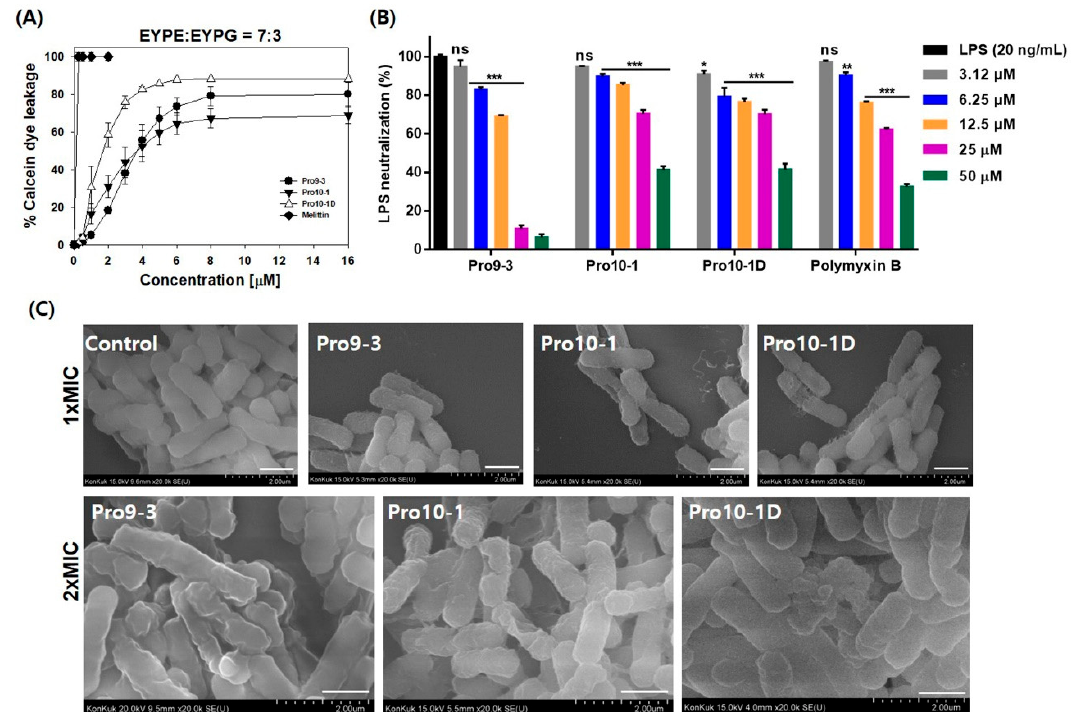
Figure 5. Antibacterial mechanism of peptides: ( A ) Dose–response curves of calcein leakage from egg yolk L- α -phosphatidylethanolamine (EYPE)/egg yolk L- α -phosphatidylglycerol (EYPG) (7:3, w/w) large unilamellar vesicles (LUVs) (induced by the peptides) were constructed. The concentration-dependent dye release indicates the membrane-permeabilizing ability of the peptides. Melittin was used as a control. ( B ) Lipopolysaccharide (LPS)-neutralizing capacity of the peptides and polymyxin B (positive control): the percentage of inhibition signifies the LPS-neutralizing abilities of peptides. ( C ) Scanning electron micrographs of E. coli (KCTC 1682) treated with peptides at 1× and 2 × of the minimum inhibitory concentrations (MICs) for 4 h: ultrastructural changes to the outer membrane of E. coli indicate the membrane damage caused by the peptides. Scale bar, 100 µm. Data are expressed as the mean ± SEM of three independent experiments and are statistically significant at * p < 0.05, ** p < 0.01, and *** p < 0.001; ns, not significant (by one-way ANOVA , Tukey’s post hoc test ).